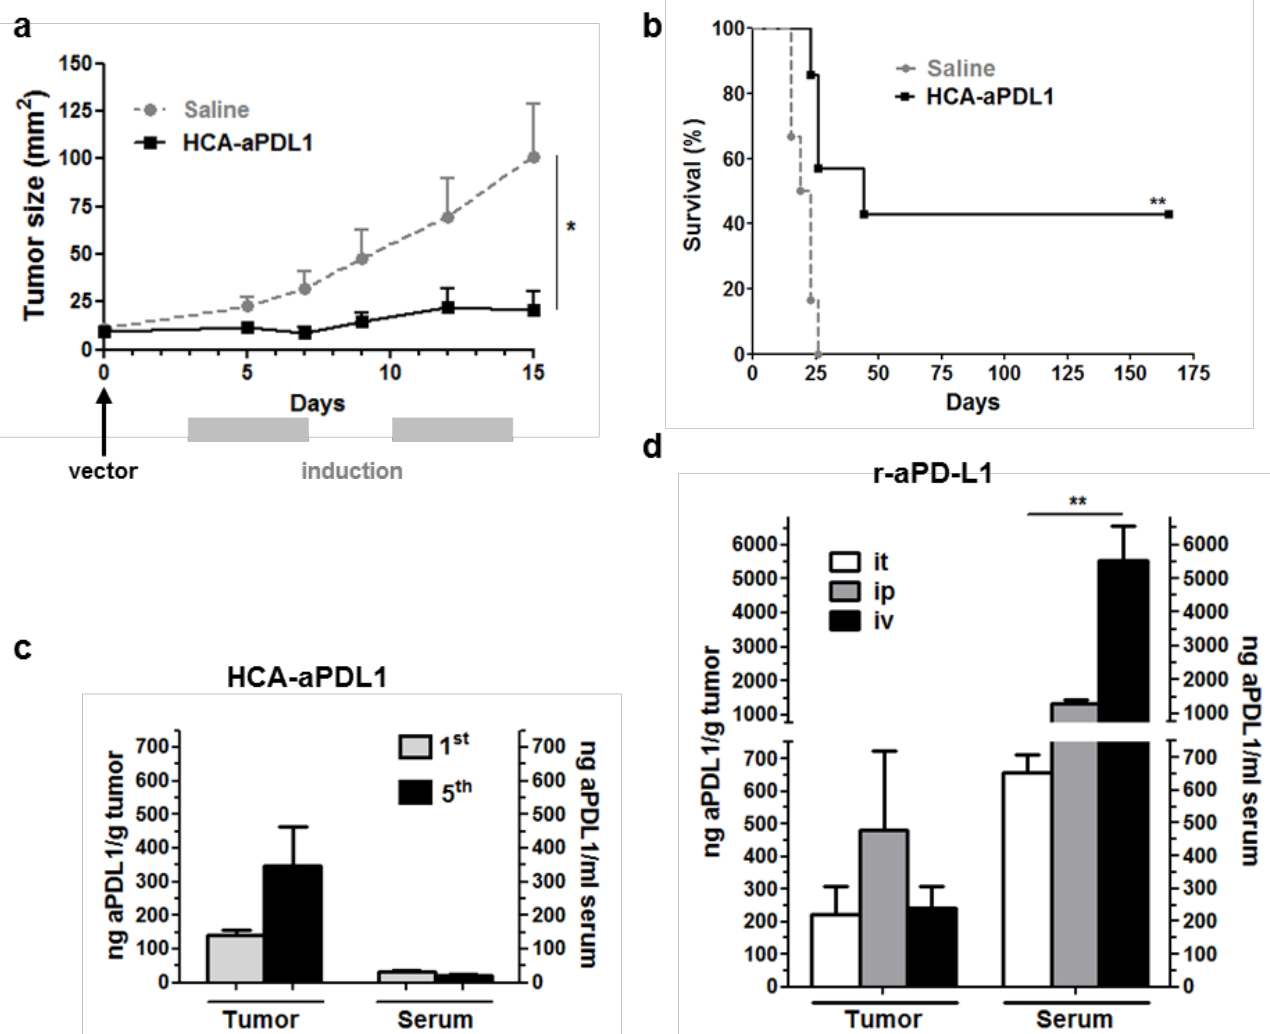
Figure 2. Intratumoral administration of HCA-EFZP-aPDL1 allows local expression of aPD-L1 and inhibition of subcuta- neous tumor growth. Tumors were established by subcutaneous inoculation of MC38 cells. The vector (1 × 10 10 vg in 50 µ L) was injected intratumorally (day 0), and the expression of aPD-L1 was activated by i.p. administration of mifepristone at days 3–7 and 10–14. ( a ) The progression of subcutaneous tumors was evaluated in mice receiving the vector (HCA-aPDL1) or saline solution as a control group ( n = 7), by direct measurement. * p < 0.05, Mann–Whitney U test. ( b ) Survival curve. ** p < 0.01 log-rank test. Data are represented as average ± SEM. ( c ) A subset of animals ( n = 5) was sacrificed 10 h after the 1st and 5th mifepristone injections (days 4 and 8) for quantification of aPD-L1 in serum and tumor extracts. ( d ) For comparison of mAb biodistribution, additional groups of mice ( n = 4) received the recombinant mAb (100 µ g every 72 h for 3 doses) following the intratumoral (it), intraperitoneal (ip) or intravenous (iv) routes. Mice were sacrificed 8 h after the last administration for quantification of aPD-L1. ** p < 0.01 Kruskal–Wallis test.